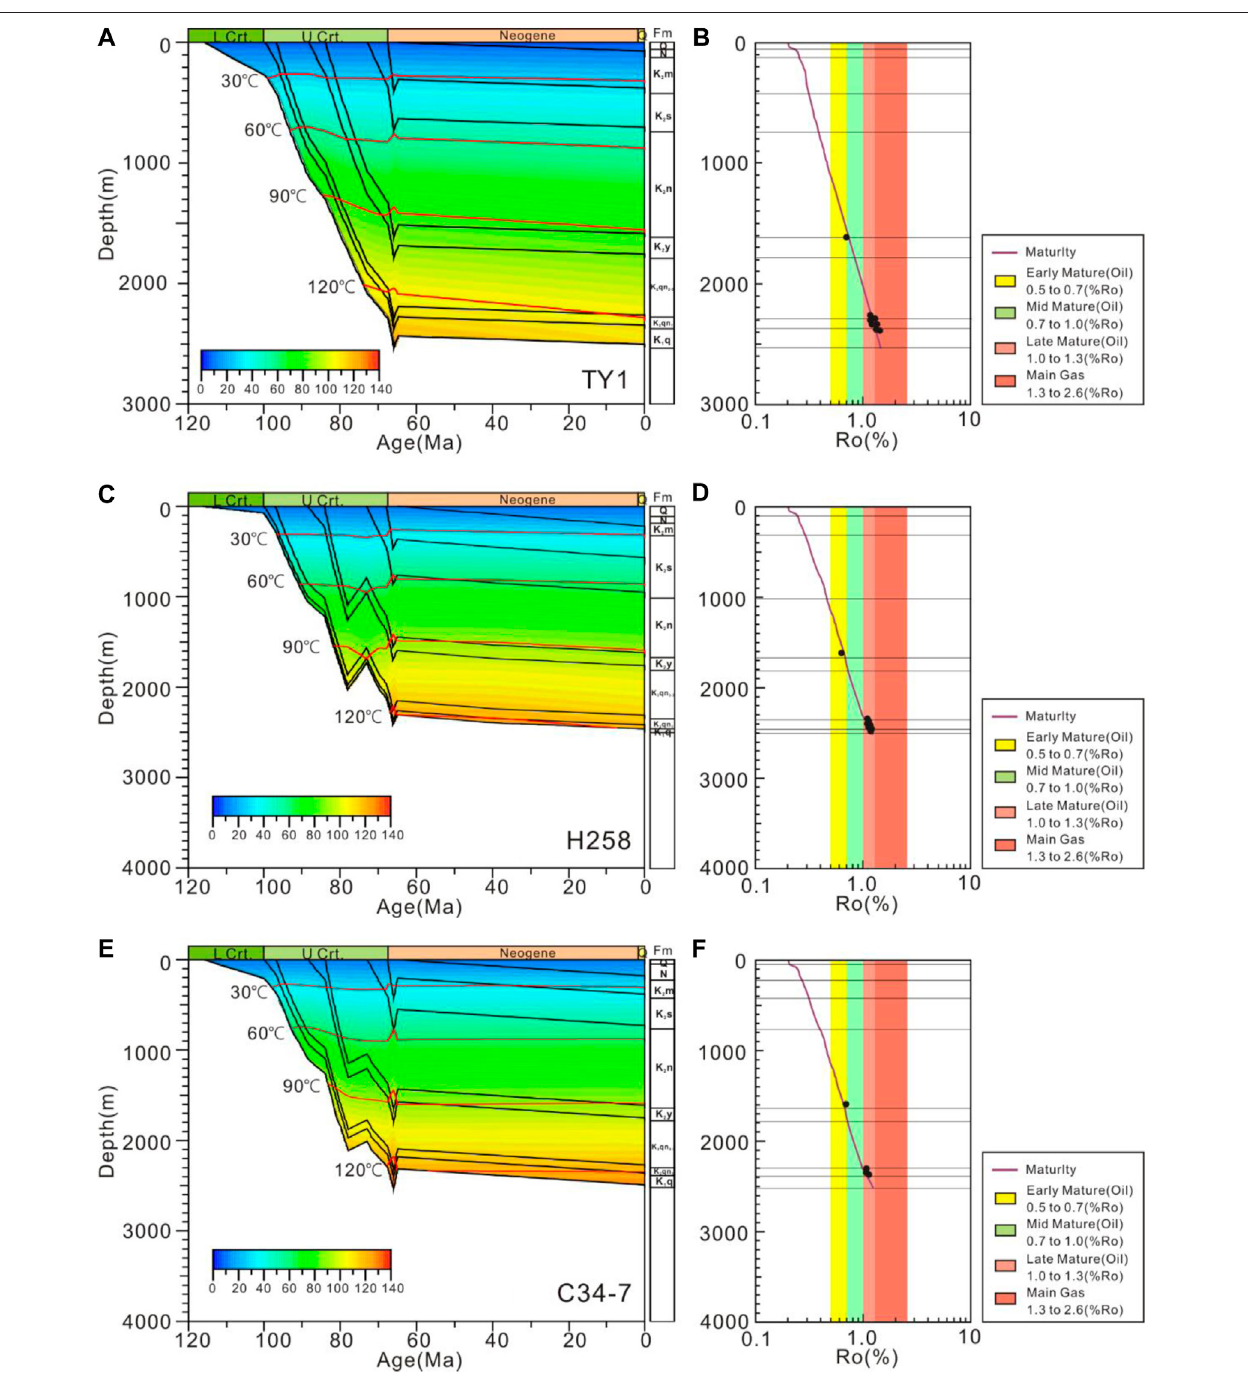
FIGURE 6| The burial histories ofthe TY1 well (A) , the H258 well (C) and the C34-7 well (E) , and the thermal models ofthe TY1 well (B) , the H258 well (D) and the C34-7 well (F) in the southern part of the Songliao Basin.